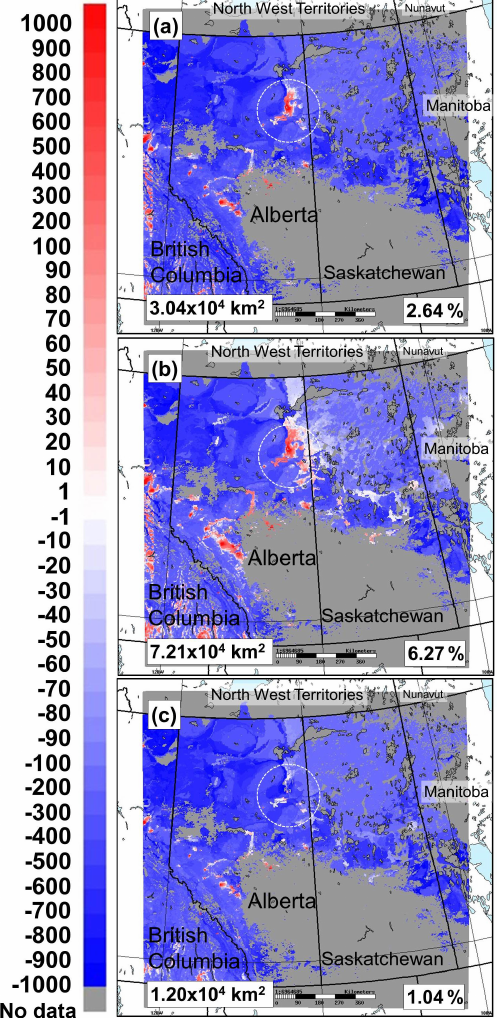
Figure 14. Predicted forest ecosystem critical load exceedances with respect to acidity (S + N deposition), using NEG-ECP (2001) methodologies (eqha − 1 yr − 1 ). White to red regions: exceedance, white to blue regions: below exceedance. (a) GEM-MACH S + N deposition, interpolated and extrapolated base cation deposition from 1994–1998 observations. Station locations for base cation ob- servations are shown as yellow diamonds. (b) GEM-MACH S + N deposition, model base cations from reported emissions of crustal material and Wang et al. (2015) cation fractionation. (c) GEM- MACH S + N deposition scaled according to precipitation observa- tions, base cations scaled using precipitation and aircraft data Lower left of each panel: total area in exceedance, in km 2 . Lower right of each panel: percentage of the entire critical load data area which is in exceedance. Circled region: 140km radius diameter circle around the Athabasca oil